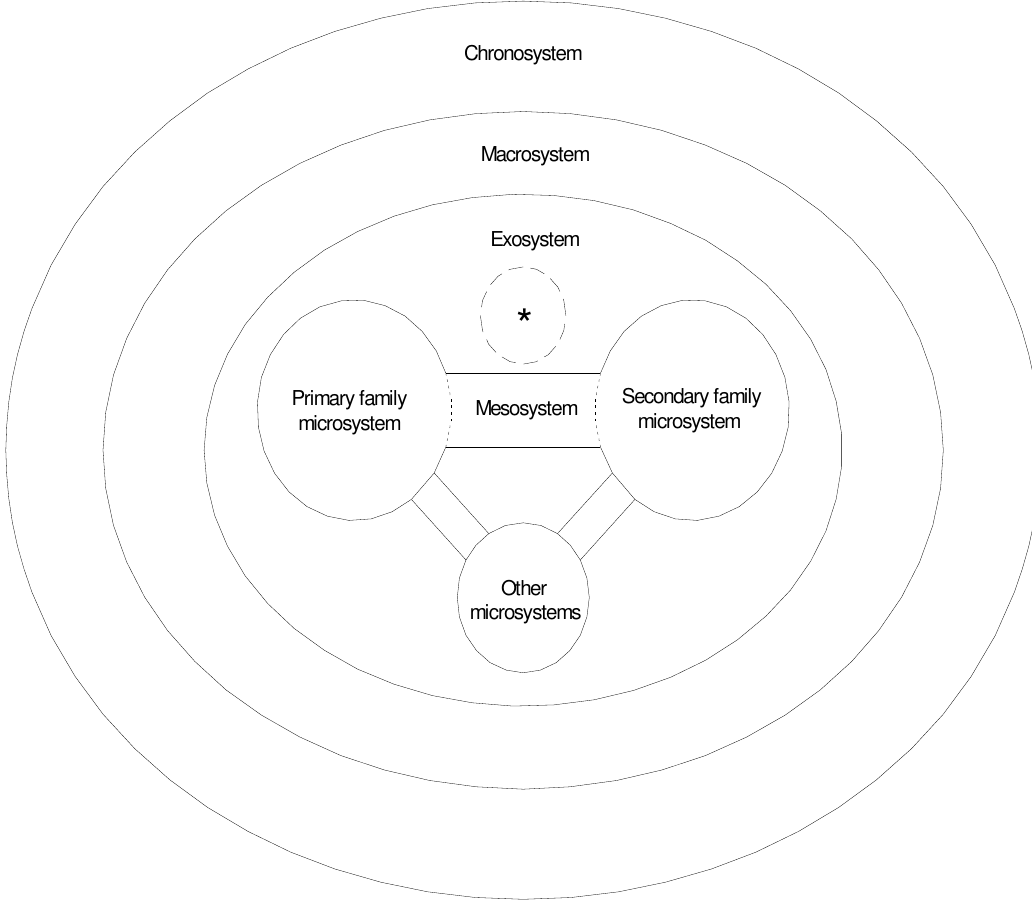
Figure 2 The bio-ecological model of a reconstituted family (Ebersohn,